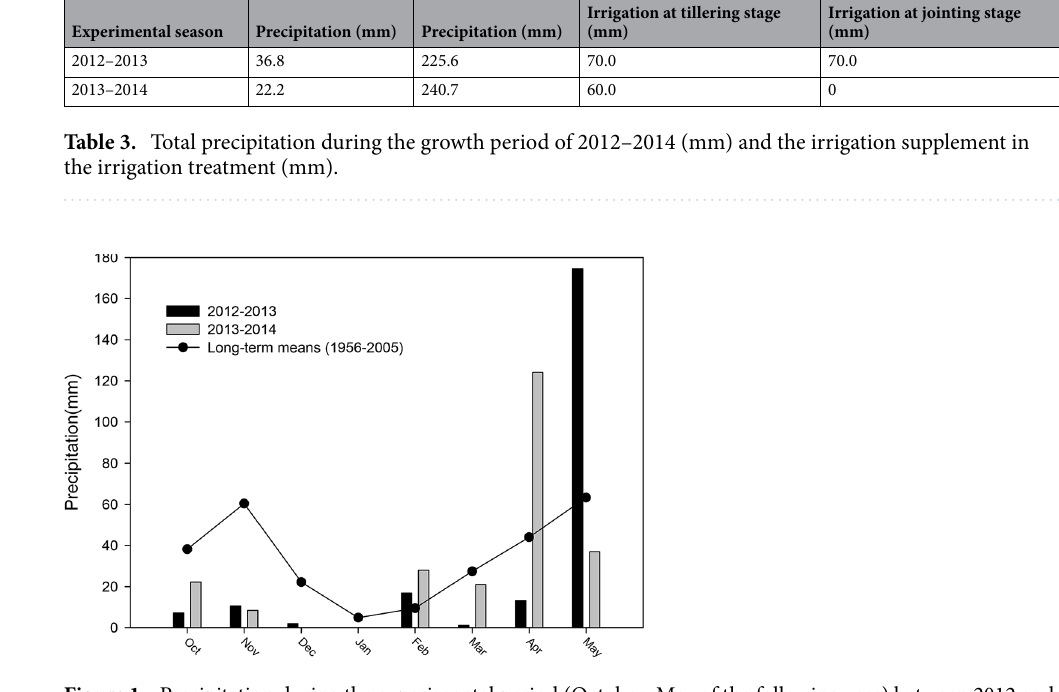
Defoliation and ear-shading. Combinations of defoliation and ear-shading were imposed at anthesis in both seasons. The anthesis date of each cultivar was evaluated based on 50% of plants per plot at anthesis. Forty main culms with similar heights and ear sizes among the 50% were selected and labeled in each plot, and they were treated 3 days after anthesis for each cultivar as described below.